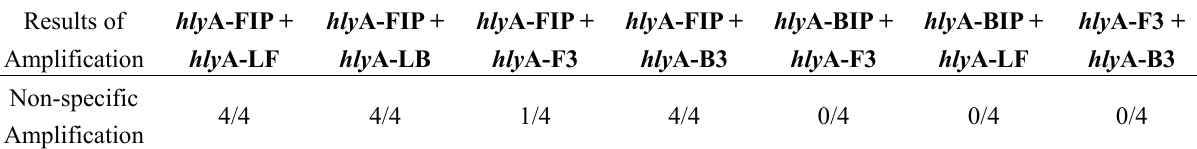
Table 1. Non-specific amplification of varying loop-mediated isothermal amplification (LAMP) primer combination.